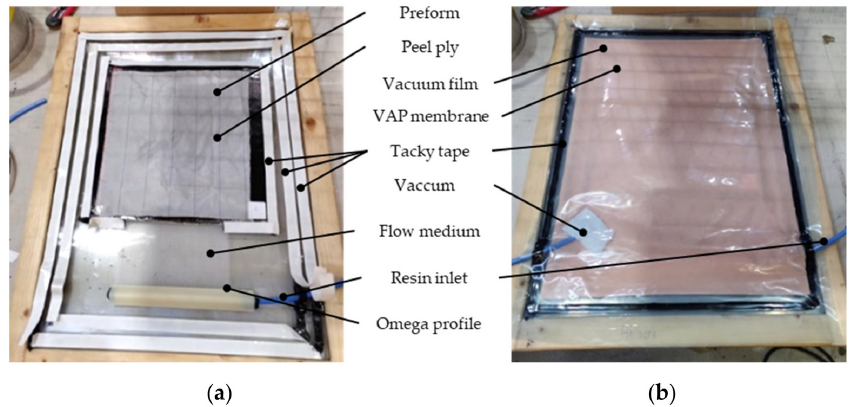
Figure 6. VAP Infusion setup: ( a ) preform and support material and sealings; ( b ) closed setup with VAP membrane, vacuum film, resin inlet, and vacuum tube, no vacuum applied